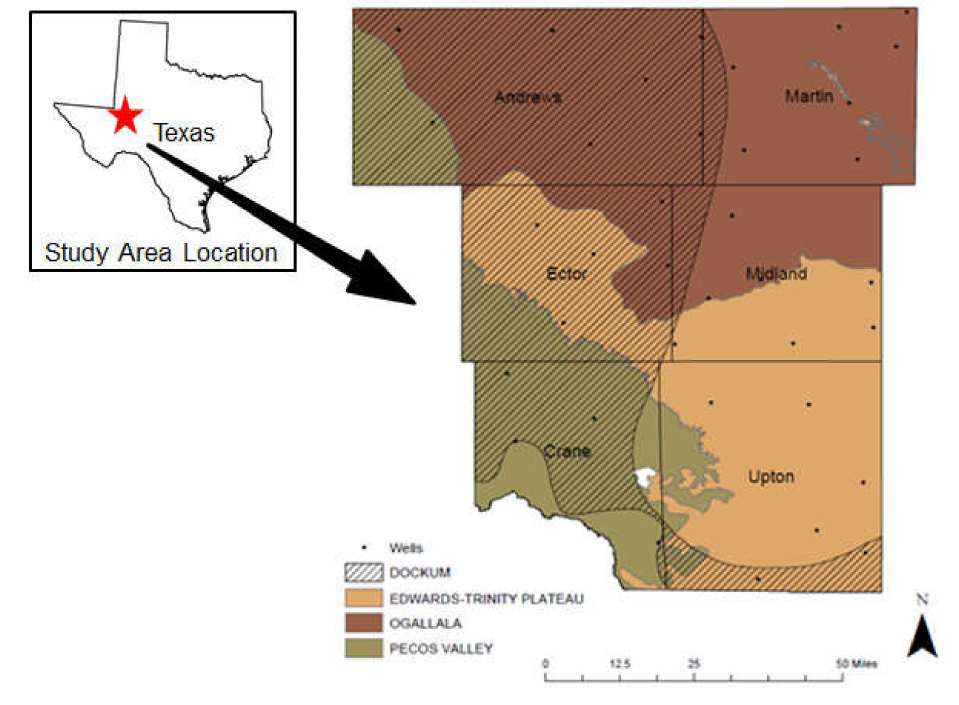
Figure 1. Study area map showing well locations, county and aquifer